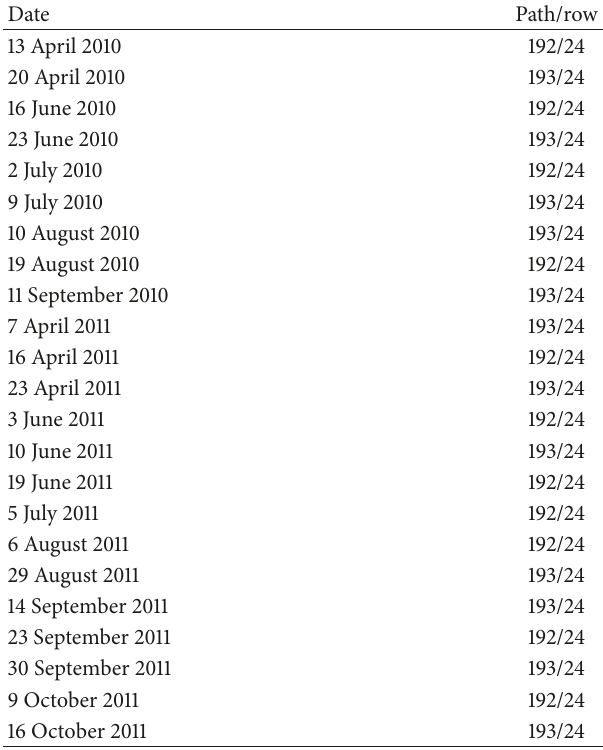
Table 2: Landsat 7 ETM+ scenes used for